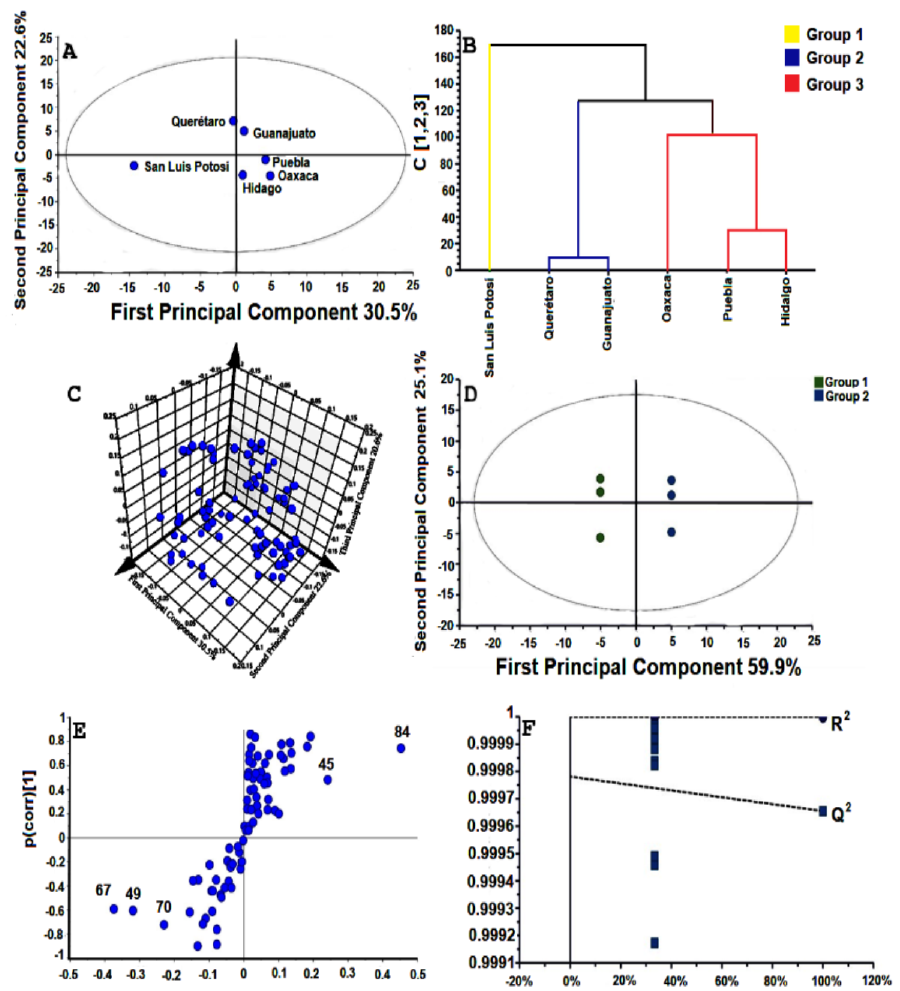
Figure 8. Chemometrics analysis of Brickellia veronicifolia . ( A ) Results of PCA from studied pop- ulations. ( B ) Dendrogram (HCA) based in PCA approaches. ( C ) Plot of 3D PCA. ( D ) OPLS-DA score plots generated from the volatiles of different populations of B. veronicifolia. Group 1, San Luis Potos í , Quer é taro and Guanajuato; Group 2, Oaxaca, Puebla and Hidalgo. ( E ) S-plot discriminant analysis with potential chemical markers of B. veronicifolia . Caryophyllene oxide (84), β -elemene (45), β -caryophyllene (49), γ -cadinene (67), and (+)- δ -cadinene (70). ( F ) Statistical validation of the OPLS-DA